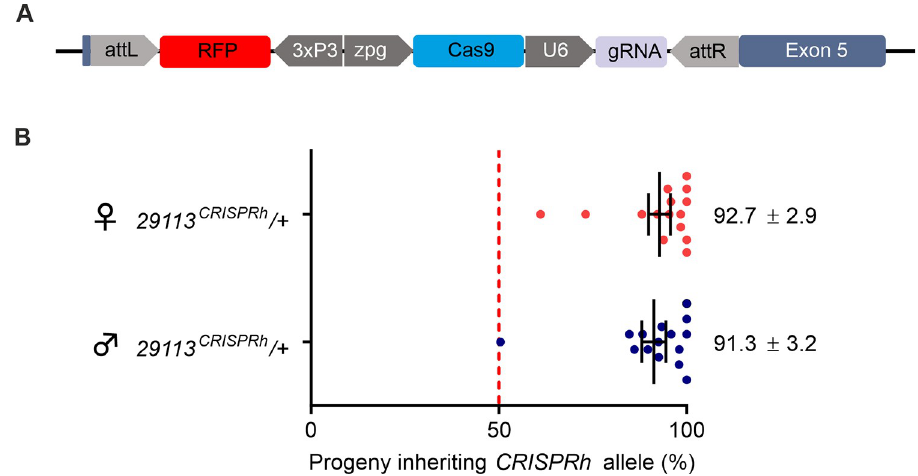
Fig 2. Construct and homing rate of the 29113 CRISPRh allele (A) Displayed is the CRISPR homing construct 29113 CRISPRh consisting of a 3xP3 :: RFP marker, Cas9 under the transcriptional control of the zpg promoter and a gRNA under the control of the ubiquitous U6 PolII which replaced the GFP transcription unit in heterozygous 29113 hdrGFP/+ lines by RCME. The gRNA cleaves at the homologous wild-type allele at the target site corresponding to the 29113 CRISPRh insertion. Repair of the cleaved chromosome through HDR leads to copying of the CRISPR h allele and homing. (B) Male or female 29113 CRISPRh /+ heterozygotes were mated to wild-type. High levels of homing of > 90% was observed. Progeny from individual females were scored for the presence of the RFP linked to the 29113 CRISPRh construct and the average transmission rate indicated by vertical bar. A minimum of 15 females were analyzed for each cross. The average homing rate ± s.e.m. is also